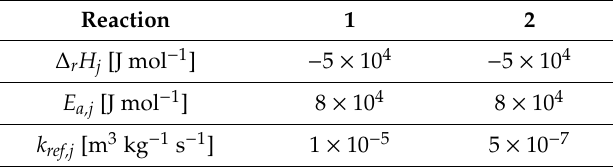
Table 3. Kinetic and thermodynamic data. T ref = 298